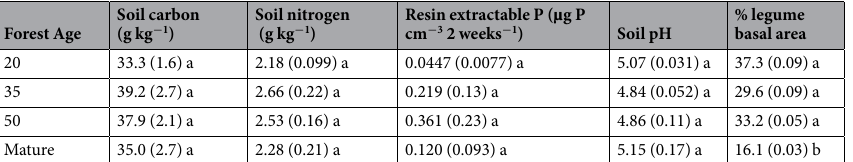
Table 1. Site and soil characteristics. Soil data represents the top 10 cm of the mineral soil. Data is presented as the means with standard error in parentheses; n = 5. Letters indicate significant groupings (p < 0.05; Tukey or Nemenyi test; see methods for